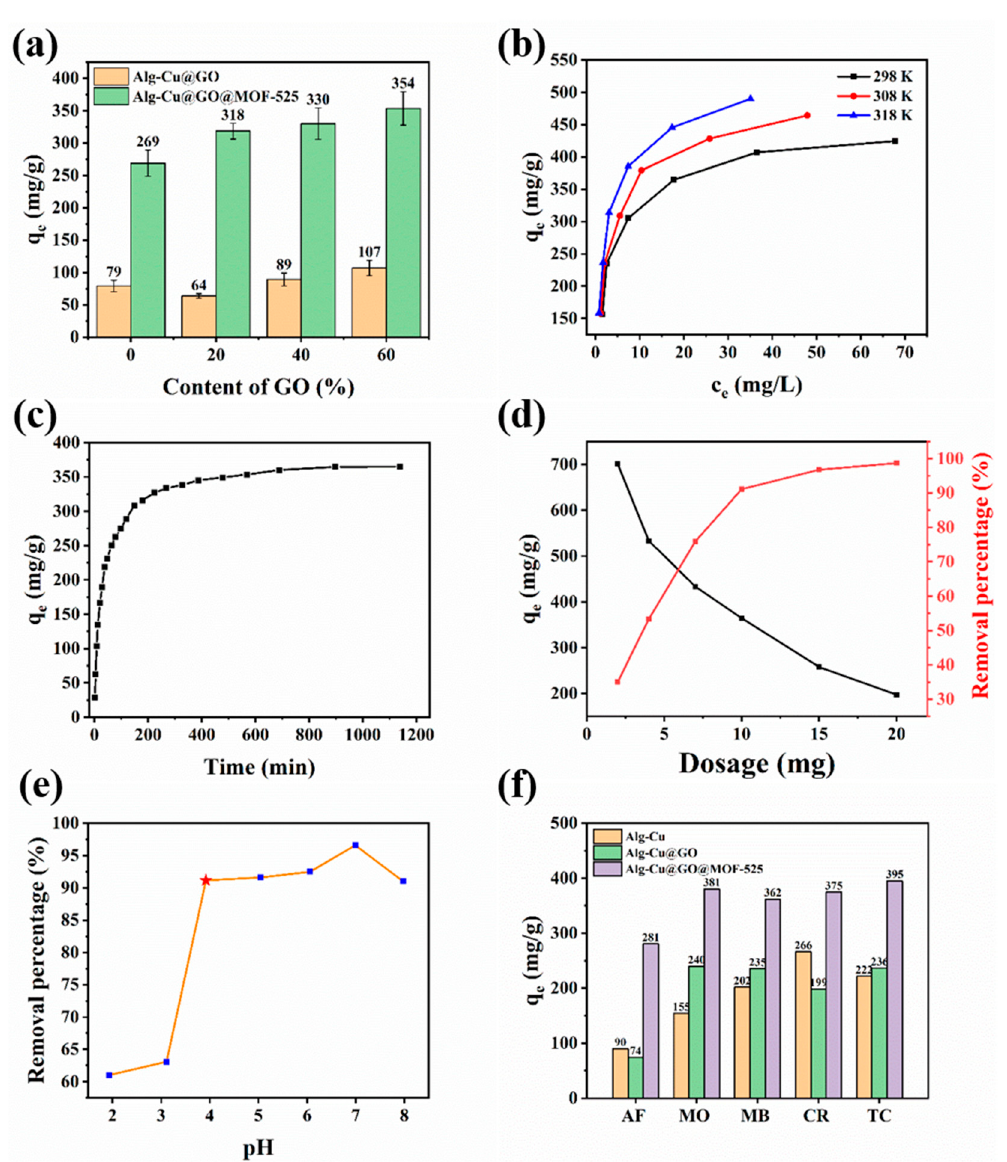
Figure 4. Effect of different experimental parameters on the adsorption of TC by Alg-Cu@GO@MOF- 525: ( a ) GO content, ( b ) pH, ( c ) dosage, ( d ) temperature, ( e ) contact time, and ( f ) different dye molecules (AF, MO, MB, CR).